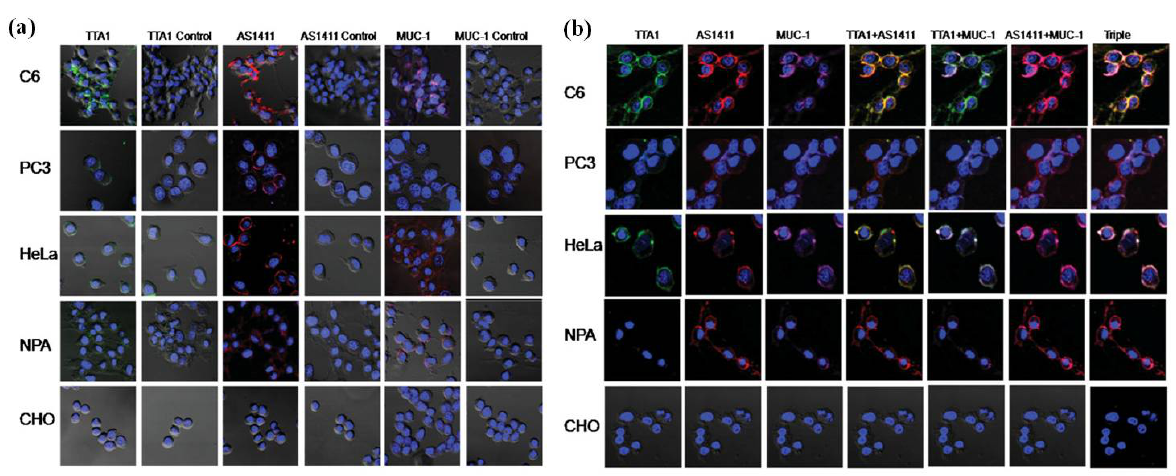
Figure 3. Confocal microscopy imaging of cells treated with QD-aptamer conjugates. ( a ) A single incubation of QD605-TTA1, QD655-AS1411, or QD705-MUC-1 was